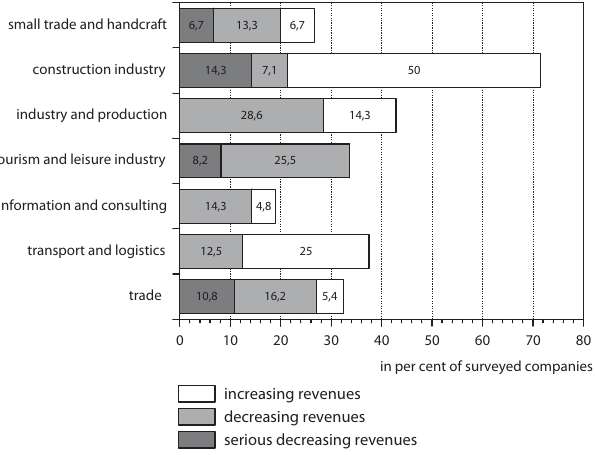
Fig. 4. Companies’ estimates of sectoral financial impacts in terms of changing revenues, n =